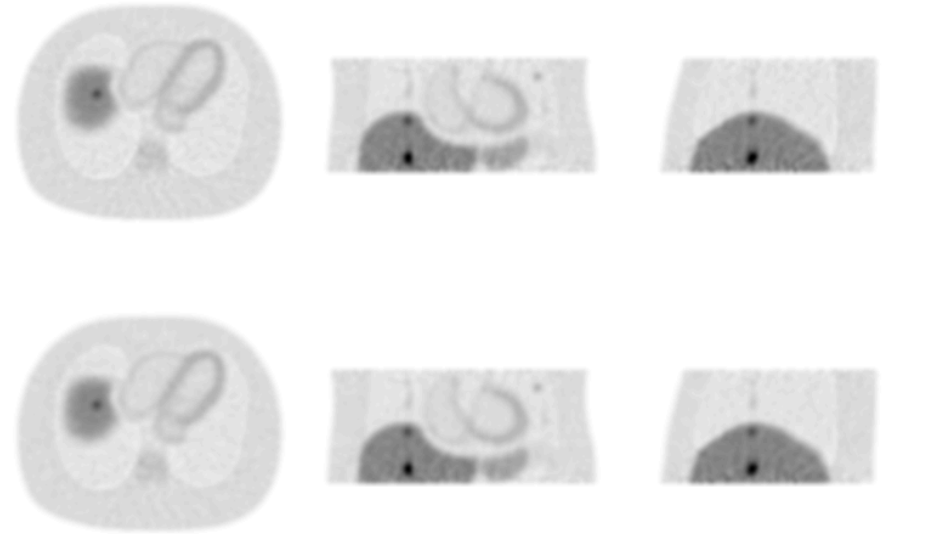
Figure 6. Post-smoothed images (6 mm FWHM Gaussian) of the NCAT phantom, resulting from the reconstructions in Figure